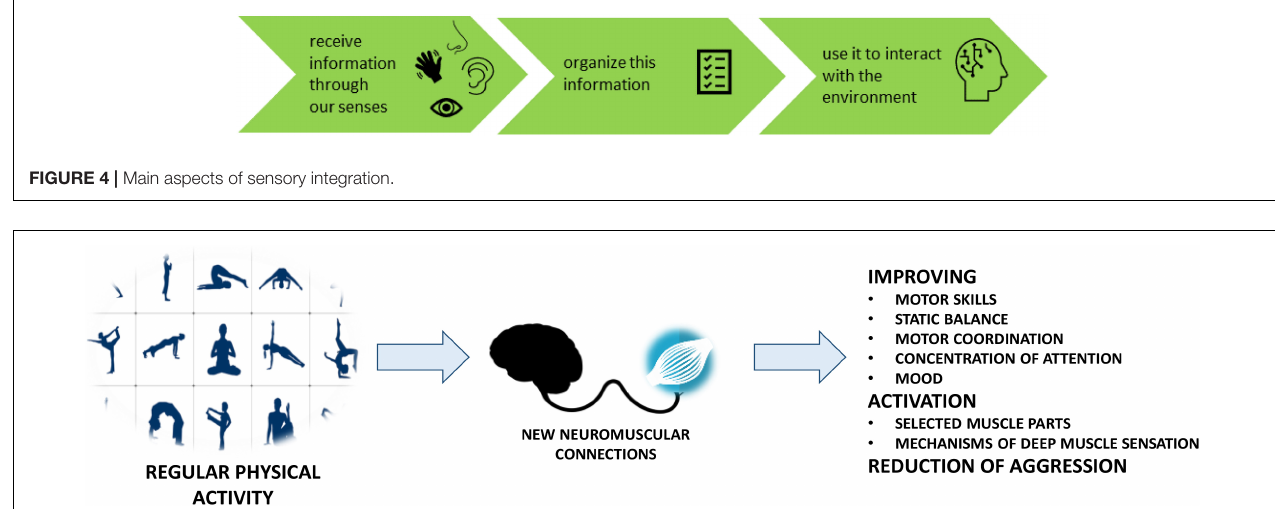
FIGURE 5 | The role of physical activity in ASD therapy.